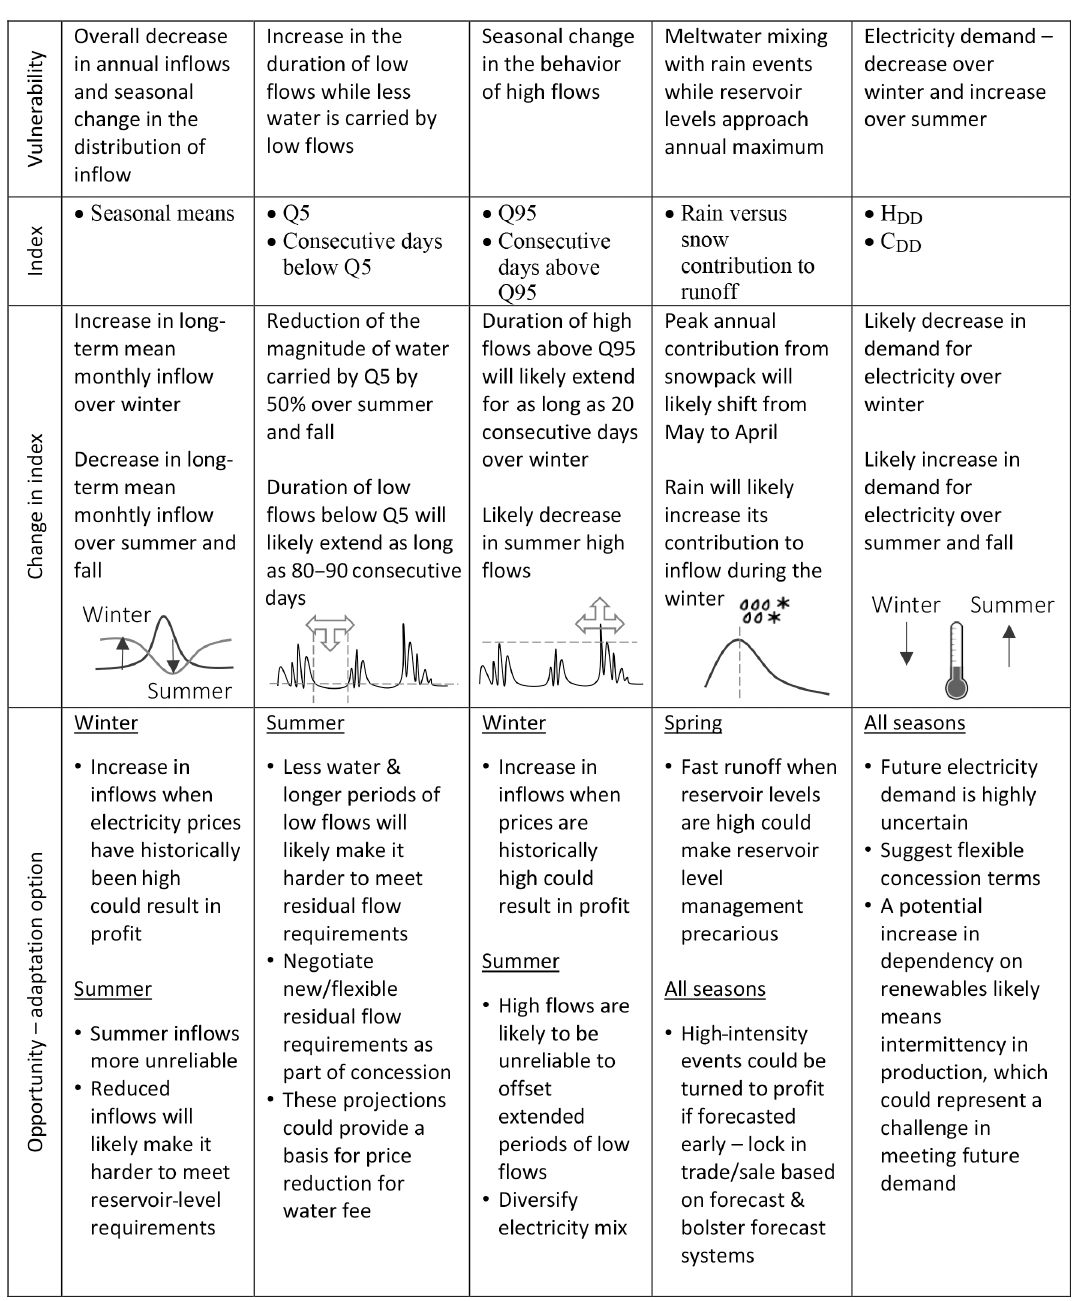
Table 4. The major opportunities and risks for hydropower operations presented in relation to the hydrological and climatological consider- ations for concession